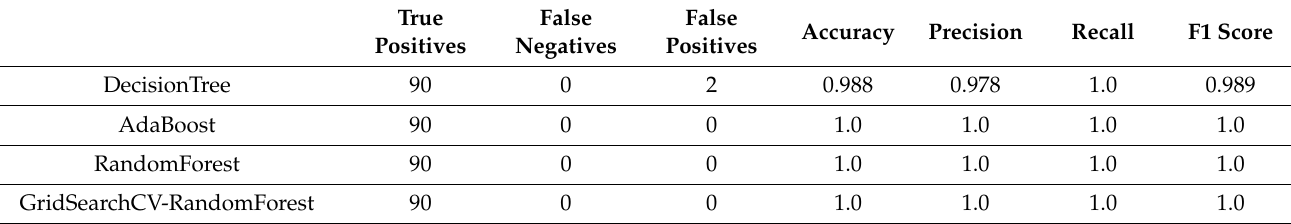
Table 6. PowerCons